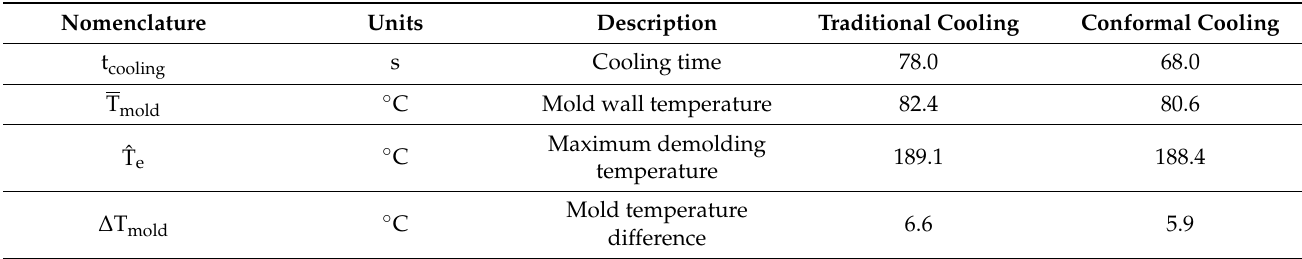
Table 9. Magnitude of the technological parameters evaluated for the traditional and conformal type refrigeration design, in the geometric region of the collimator.